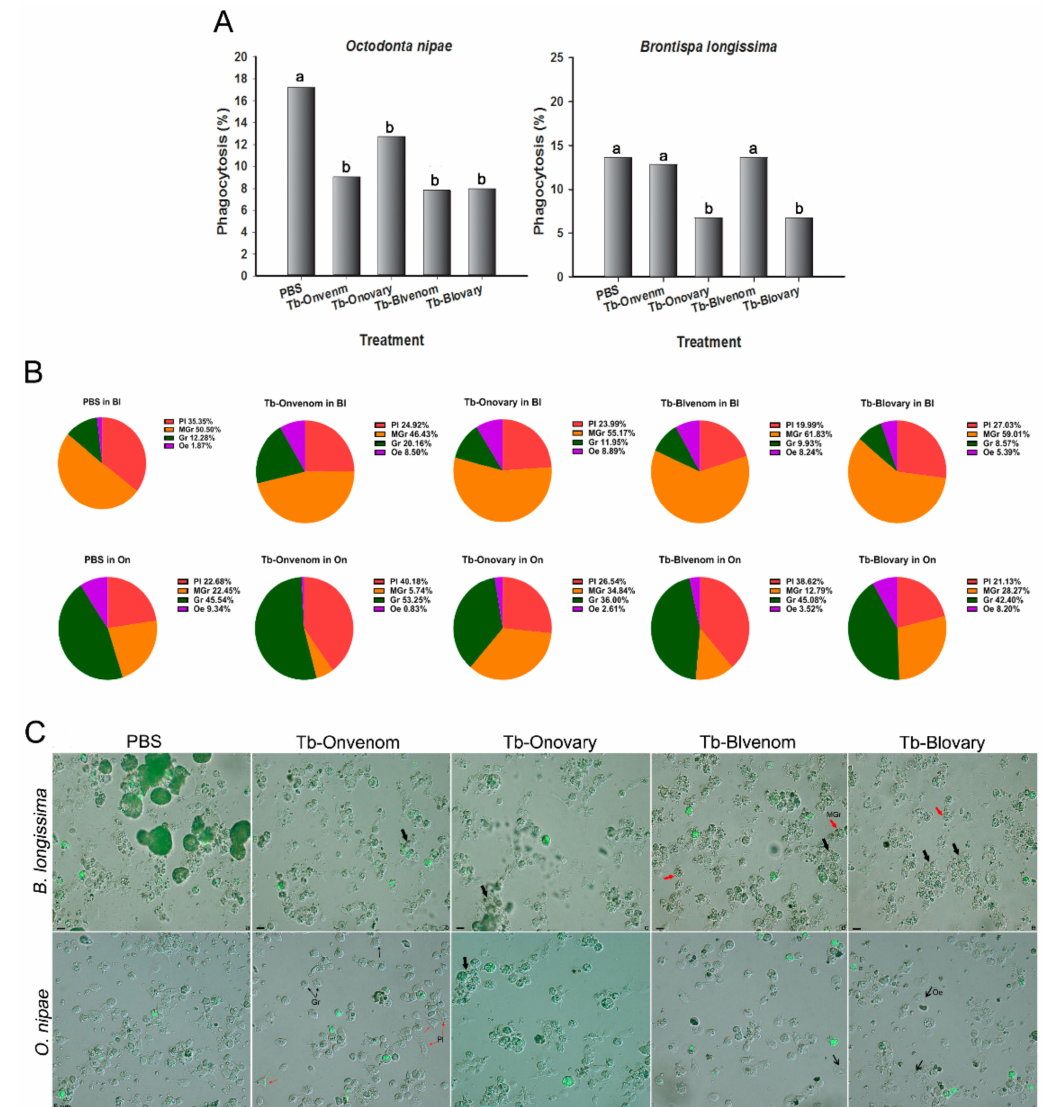
Figure 3. Haemocyte phagocytosis assay in O. nipae and B. longissima pupae after the injection with virulent factors. O. nipae or B. longissima pupae were pre-injected with virulent factors for 12 h followed by injections with heat-inactivated FITC-labelled E. coli for another 12 h. Pupae injected with PBS were used as a control group. ( A ) Phagocytosis rate after treatments. Different lowercase letters represent a significant difference at the p < 0.001 level (R × C chi -square test). ( B ) DHCs of O. nipae and B. longissima pupae injected with virulent factors and FITC-labelled E. coli . Pl, plasmatocyte (red); Gr, granulocyte (green); MGr, macrogranulocyte (orange); Oe, oenocytoid (purple). ( C ) Haemocytes visualised by differential interference microscopy and fluorescence images. Green fluorescence corresponds to FITC-labelled E. coli . Aggregates and macrogranulocytes are marked with thick black and red arrows, respectively. Pl and Gr are marked with thin red and black arrows, respectively. Scale bars, 5 µ